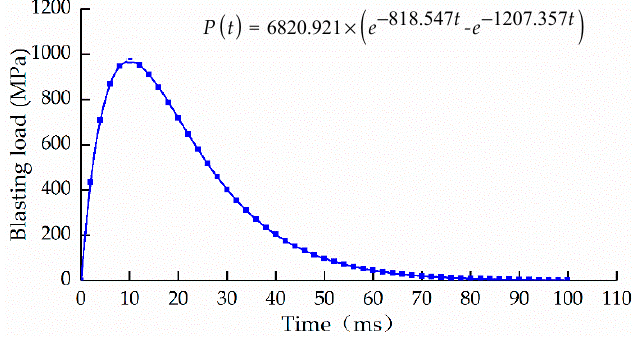
Figure 14. Computational model diagram. ( a ) Overall module. ( b ) Enlarged view of vault hole.